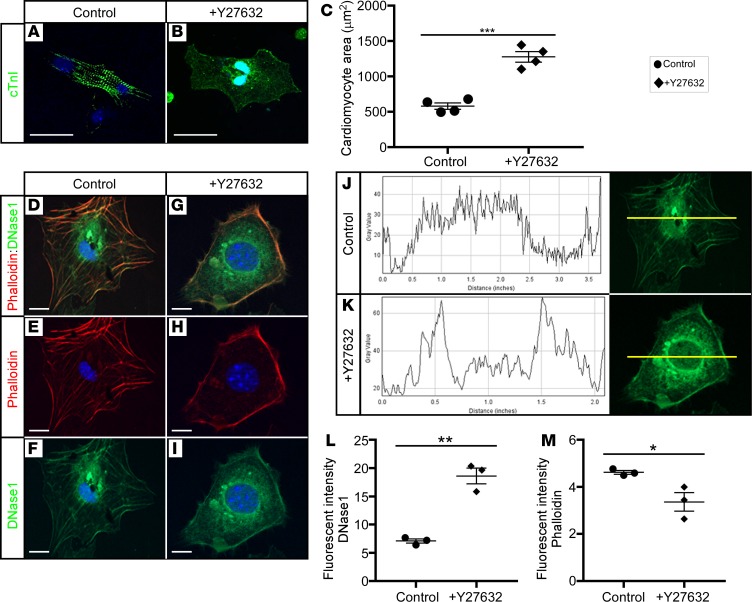
Loss of sarcomere structure and increased hypertrophy in primary cardiomyocytes after treatment with the ROCK inhibitor Y27632.Primary cardiomyocytes from E17.5 control embryos were cultured, and half were treated with the ROCK inhibitor Y27632. Cardiomyocytes were identified by staining with cTnI antibody, which stains sarcomeres (green). In the control group, the organized structure of the sarcomeres was clearly visible (A), whereas addition of Y27632 abolished the sarcomeric structure, and the cardiomyocytes appeared hypertrophic (B) compared with untreated control cardiomyocytes. (C) Cardiomyocyte area was calculated using ImageJ. The average cell area was calculated from a total of 10 cells from each treatment group, and the measurements confirmed that there is a significant increase in cell size with the addition of Y27632. n=4. (D–I) To analyze the actin composition of the cultured cardiomyocytes, we stained for G-actin (DNase I, green staining) and F-actin (phalloidin, red staining). Staining of both phalloidin (H) and DNase I (I) was disrupted in Y27632-treated cardiomyocytes, with loss of F-actin in the cytoplasm and an accumulation of DNase I around the nuclear membrane, illustrated by the fluorescence intensity profile plots (J and K). Fluorescence intensity measurements confirmed there was a significant increase in DNase I staining (L) and a decrease in phalloidin staining (M). n = 3 biological replicates for primary cardiomyocytes. Data are represented as mean ± SEM. *P < 0.05, **P < 0.01, ***P < 0.001 by unpaired t test. Scale bars: 20 μm (A, B, and D–I).